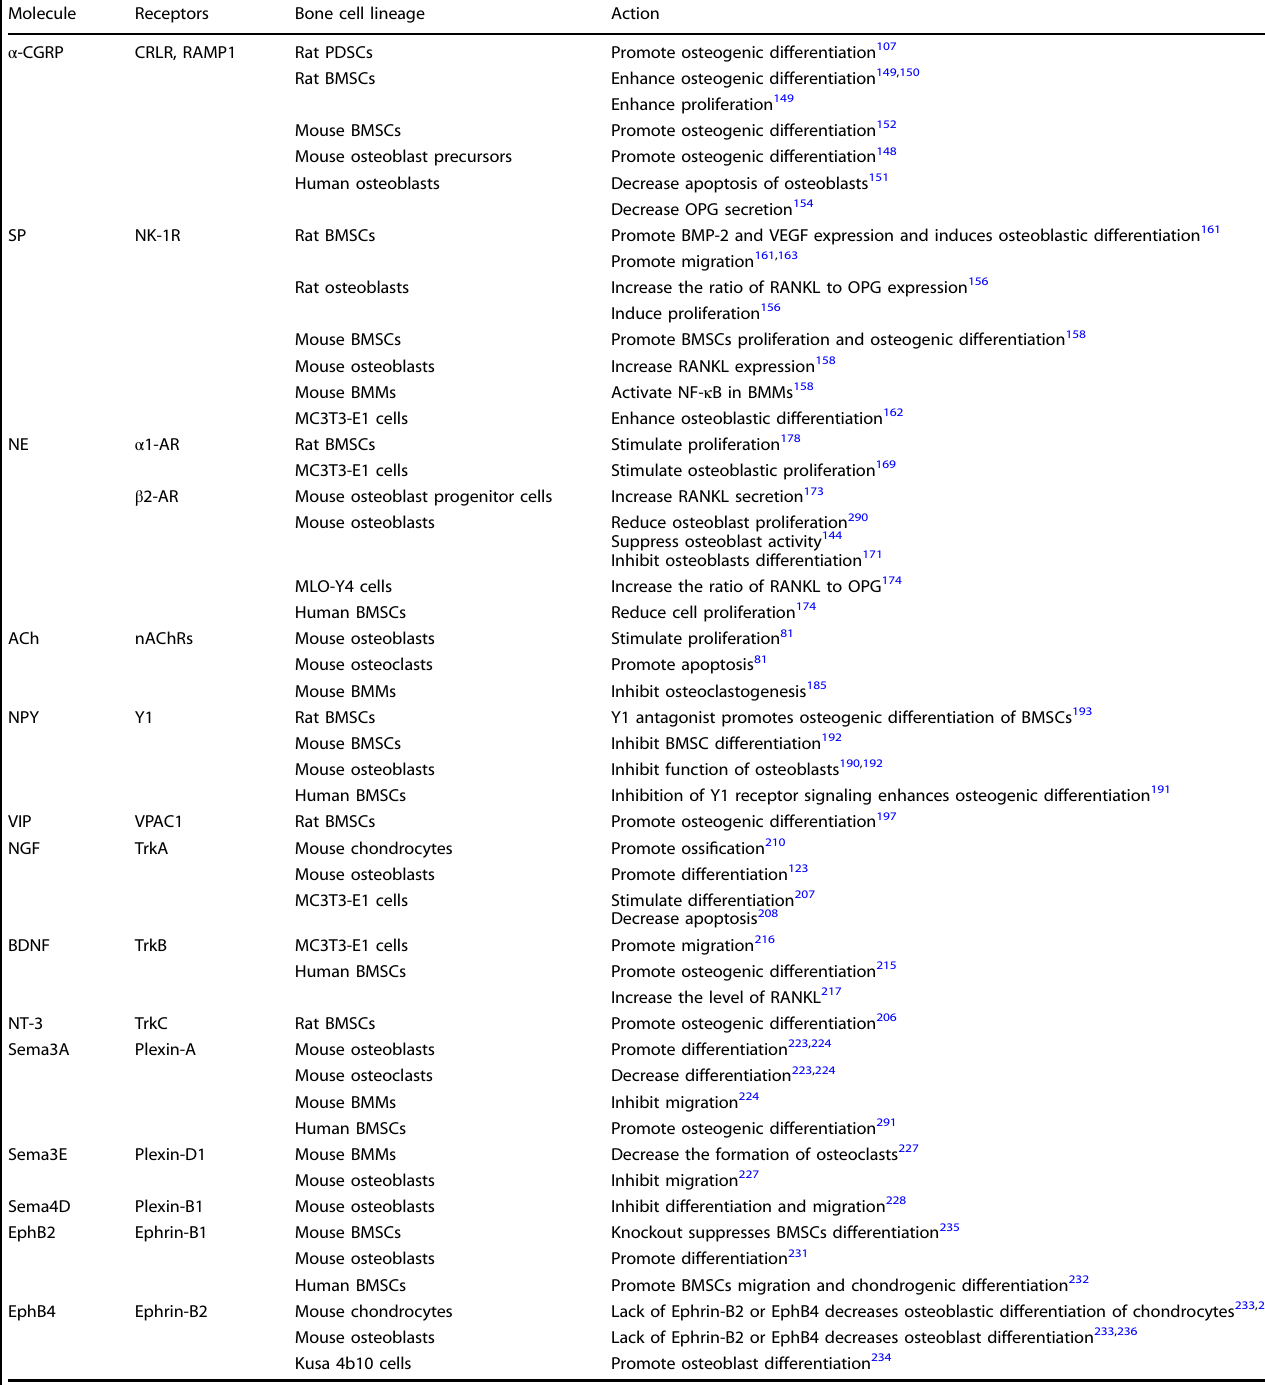
Table 1. Expression of receptors involved in PNS-mediated regulation of bone regeneration in corresponding bone cell lineages Molecule